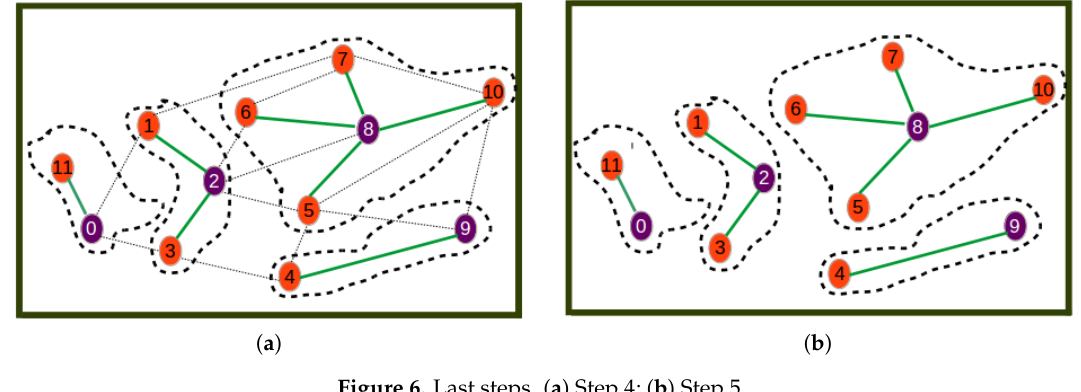
Figure 6. Last steps. ( a ) Step 4; ( b ) Step